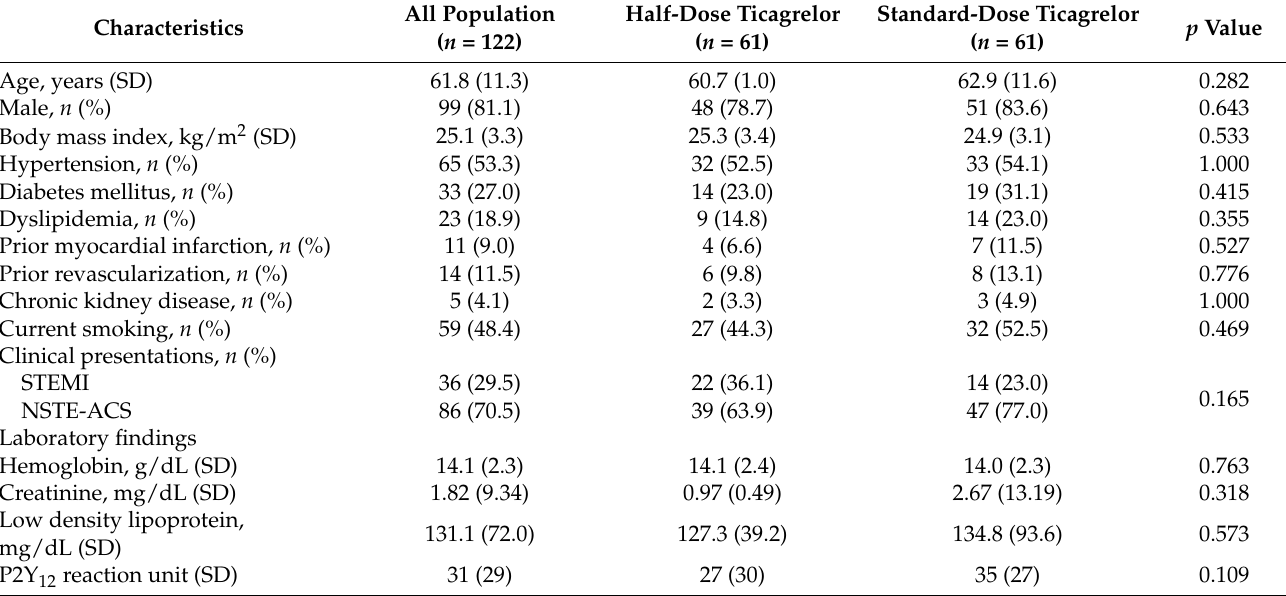
Table 1. Baseline Table 1. Baseline characteristics.